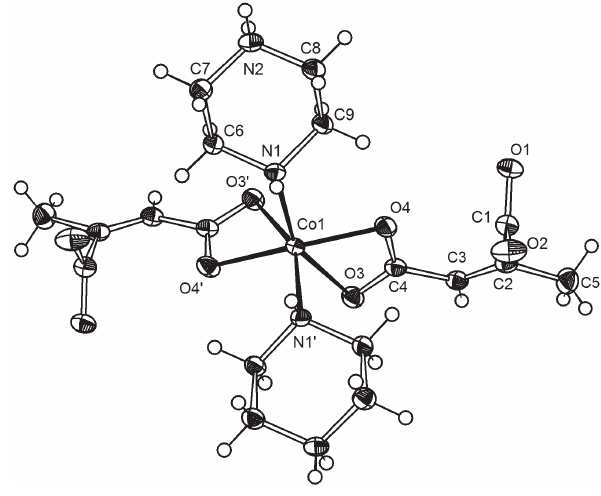
Table 1: Data collection and handling.